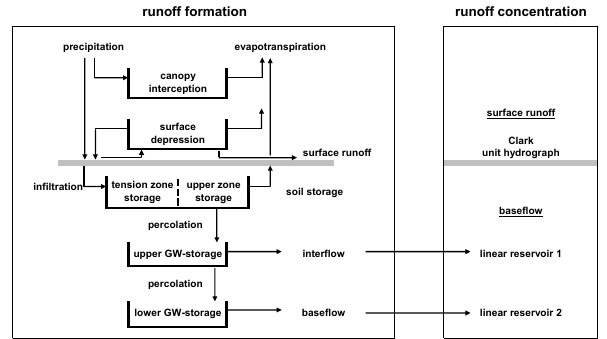
Fig. 3. HEC-HMS model (adapted from Feldmann, 2000). Figure 3 . HEC-HMS model (adapted from Feldmann, 2000)